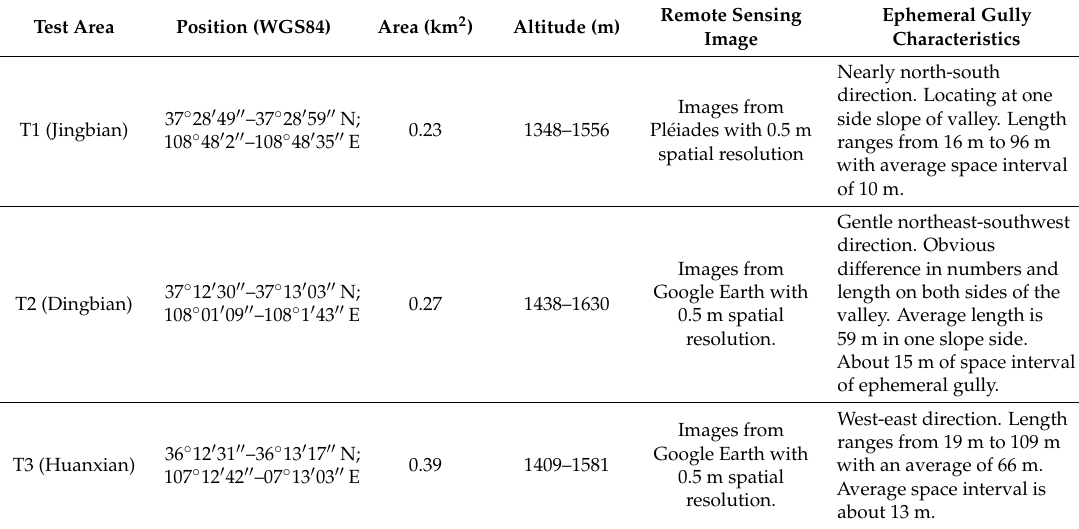
Table 1. Information on areas and data